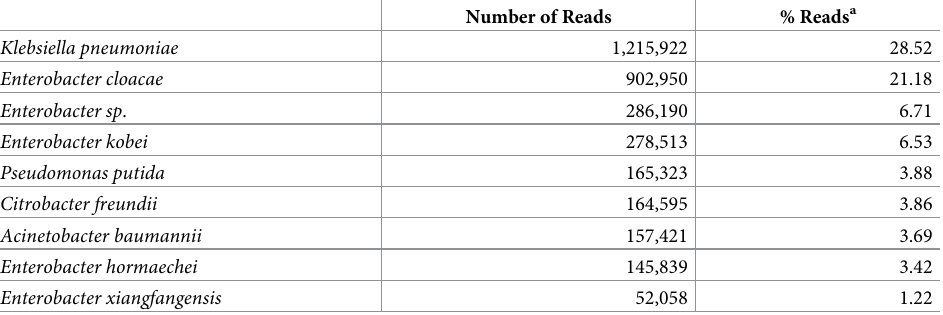
Table 1. Bacterial community analysis of enriched irrigation water by WIMP. Only species with frequencies above 1% are shown. Number of Reads % Reads a Klebsiella pneumoniae 1,215,922